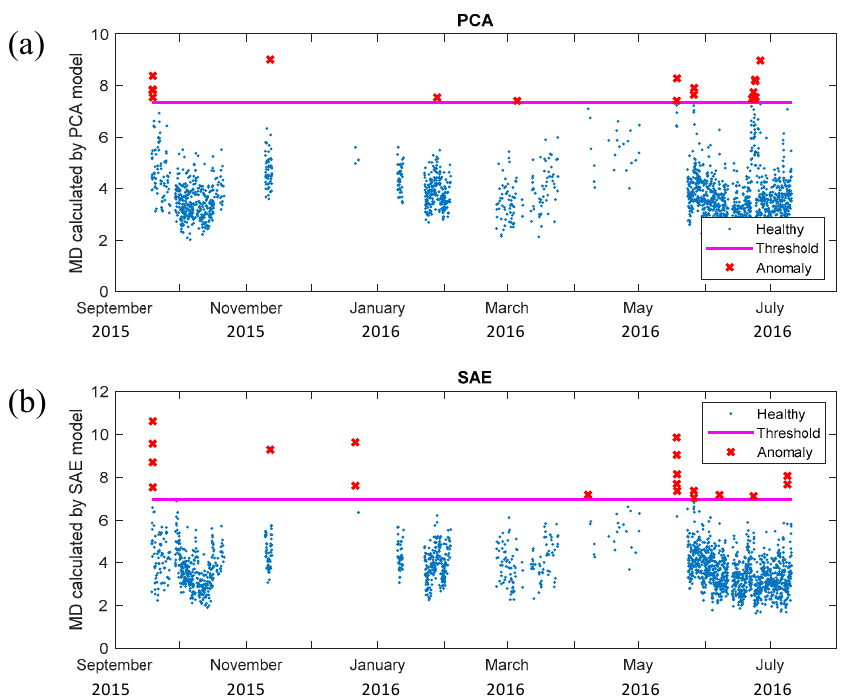
Figure 10. MD fault detection thresholds calculated during the training stage from 1 September 2015 to 11 July 2016 of the pump. ( a ) MD threshold calculated by PCA. ( b ) MD threshold calculated by SAE. (Blue points: healthy data; red points: anomalies; magenta line: reference MD thresholds.)